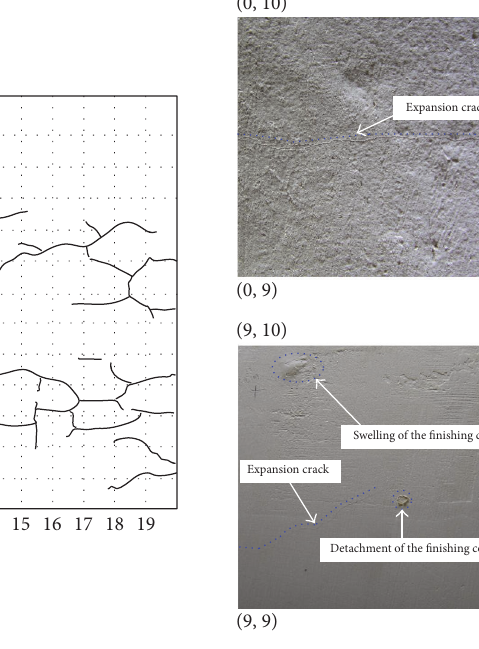
Figure 15: Crack propagations on the finishing coat, the 20 cycles.